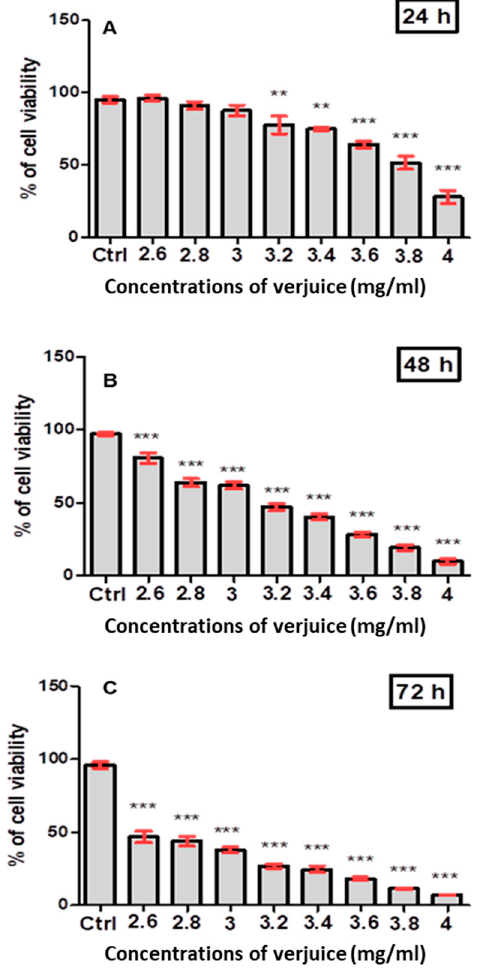
Figure 2. Effect of different concentrations of verjuice on the survival of A549 after ( A ) 24 h, ( B ) 48 h, and ( C ) 72 h of treatment. The results are expressed as the percentage of control cell (0 mg / mL verjuice) viability (Ctrl). Each value represents the mean ± SD of triplicates obtained from five independent experiments. ** p < 0.01; *** p < 0.001.